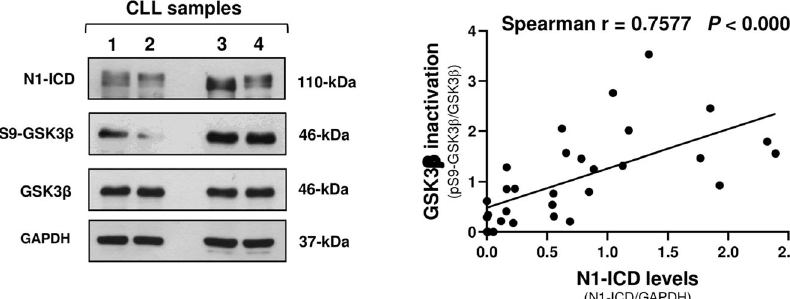
Fig. 4 Analysis of the correlation between N1-ICD and GSK3 β inactivation levels in CLL cells. Left, the expression of N1-ICD, pS9-GSK3 β used as a marker of GSK3 β inactivation status, total GSK3 β , and GAPDH used as a loading control, was examined by Western blot analysis ( n = 30). Four representative samples are shown. Right, quanti fi cation of N1-ICD bands, normalized to GAPDH levels, and of pS9-GSK3 β bands normalized to total GSK3 β levels, was performed by densitometric analysis. Correlation between N1-ICD and pS9-GSK3 β expression values was assessed by using the Spearman ’ s correlation coef fi cient ( r ). P <